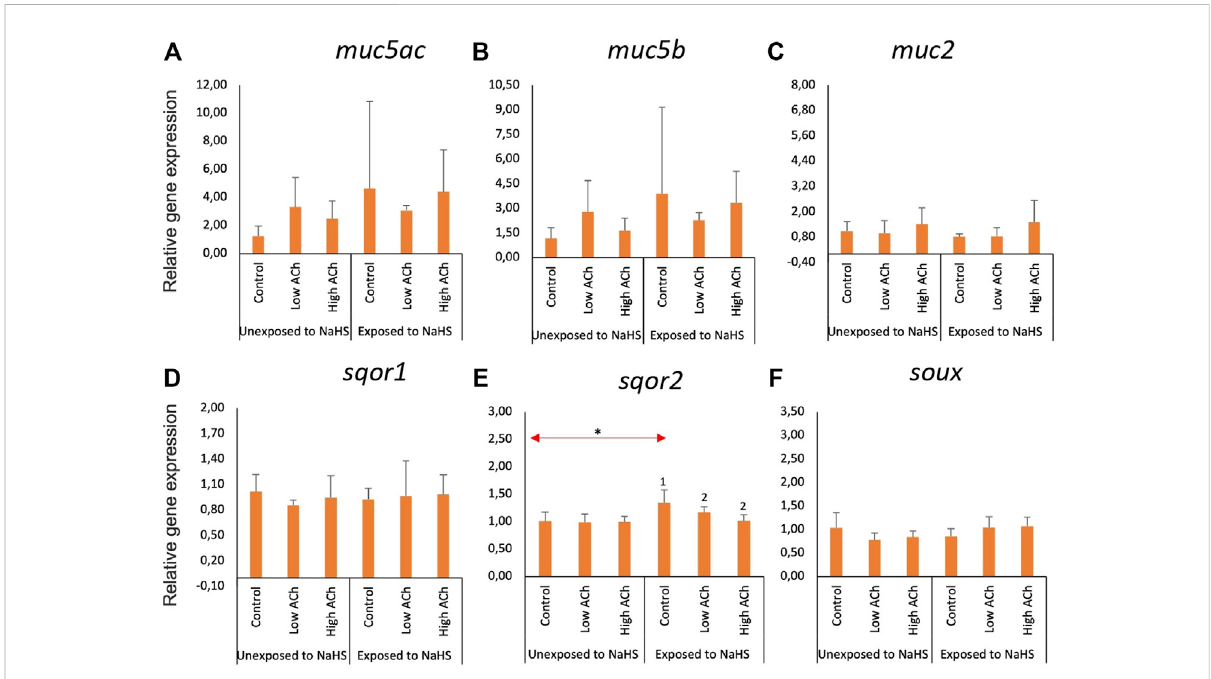
FIGURE 4 Relative gene expression of mucin genes (A – C) and sulphide-detoxi fi cation genes (D – F) in gill explants treated with acetylcholine chloride (Ach)withandwithouttheNaHSexposure.Thebarsindicatemeanandstandarddeviationofn=4.Statisticallysigni fi cantdifferences( p -value < 0.05) within samples unexposed to NaHS are denoted with letters while numeric marks denote the differences within exposed to NaHS. Red arrows indicate signi fi cant differences across NaHS exposure ( p -value < 0.05). Please note the differences in the y